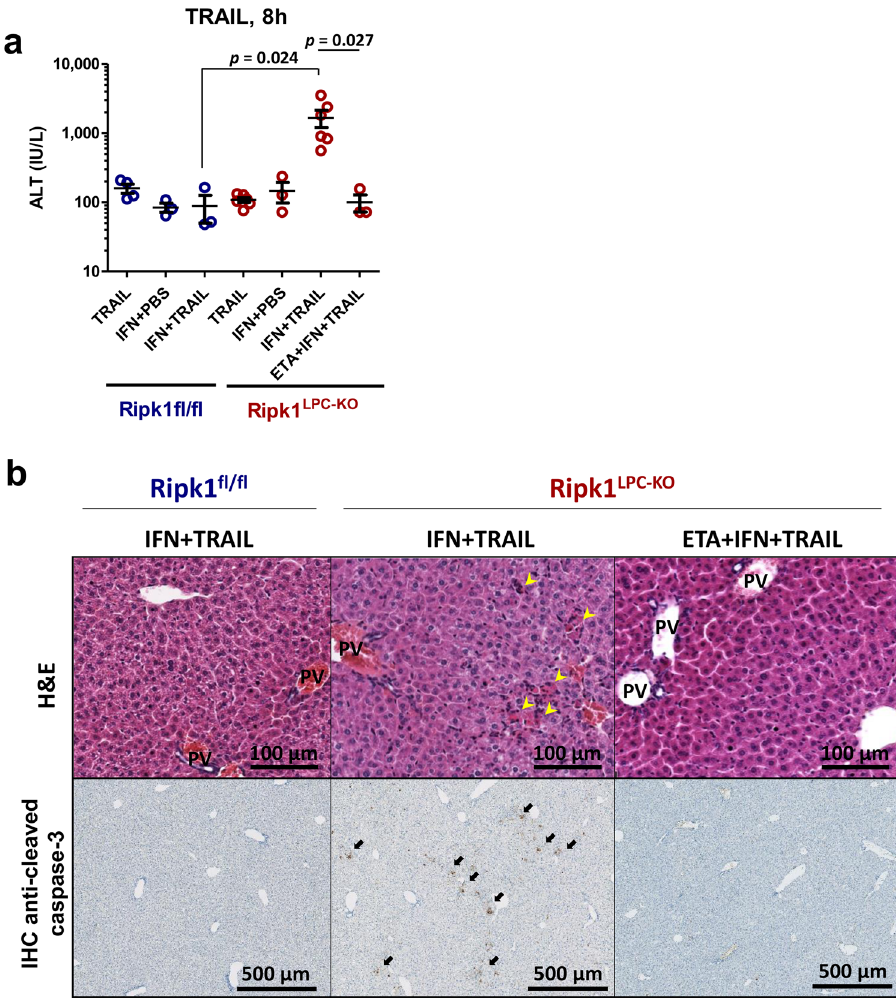
Figure 5. Co-administration of IFN- γ and TRAIL promotes liver injury in Ripk1 LPC-KO mice in a TNF- α dependent manner. ( a ) Levels of serum ALT, 8 h after TRAIL or PBS injection with a possible pre-treatment with IFN- γ and/or ETA in Ripk1 fl/fl and Ripk1 LPC-KO mice (n = 3–6 mice). Each circle represents an individual. ( b ) Pictures of liver tissue sections, stained by H&E (upper panels) or analysed by IHC for cleaved caspase-3 (lower panels), issued from Ripk1 fl/fl and Ripk1 LPC-KO mice, 8 h after TRAIL injection, pre-treated 2 h before with IFN- γ and with a possible pre-treatment with ETA. Yellow and black arrows respectively show necrotic areas and apoptotic hepatocytes, PV: portal